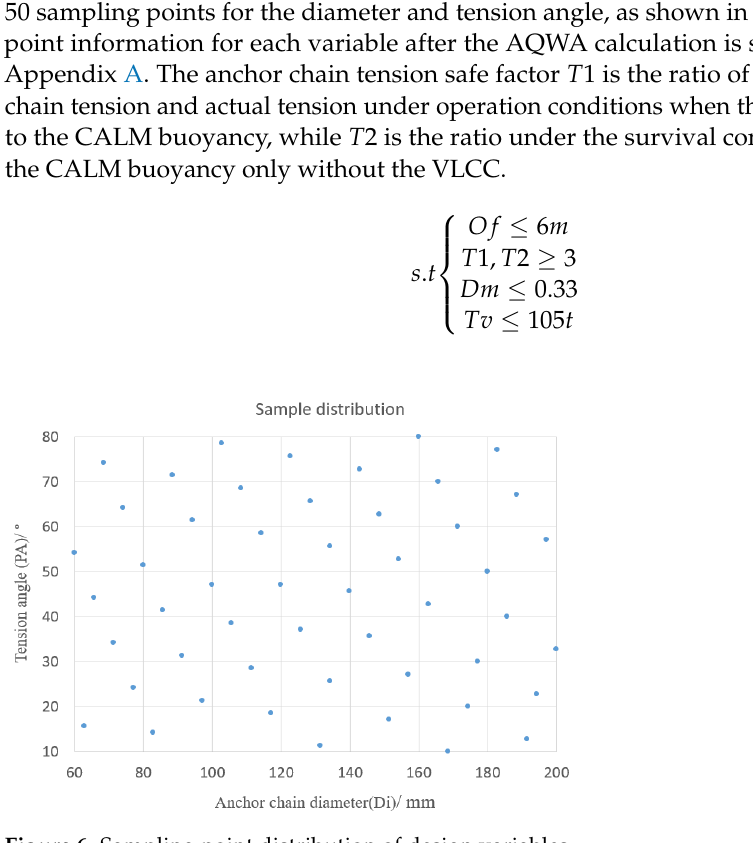
Figure 5. Schematic diagram of the adaptive sampling process.